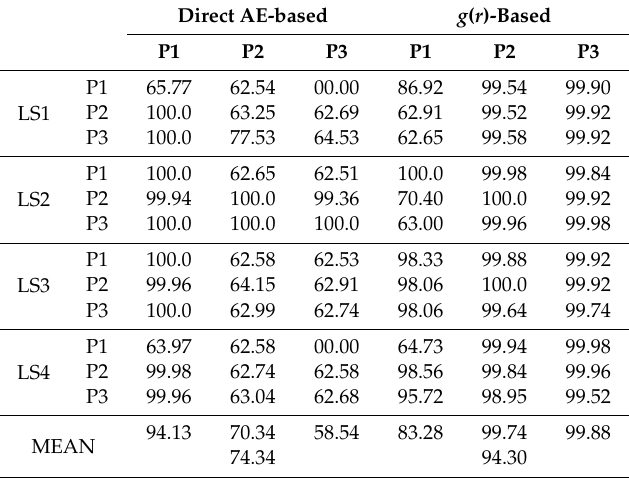
Table 8. Accuracy (%) of classifiers trained with leak L2.